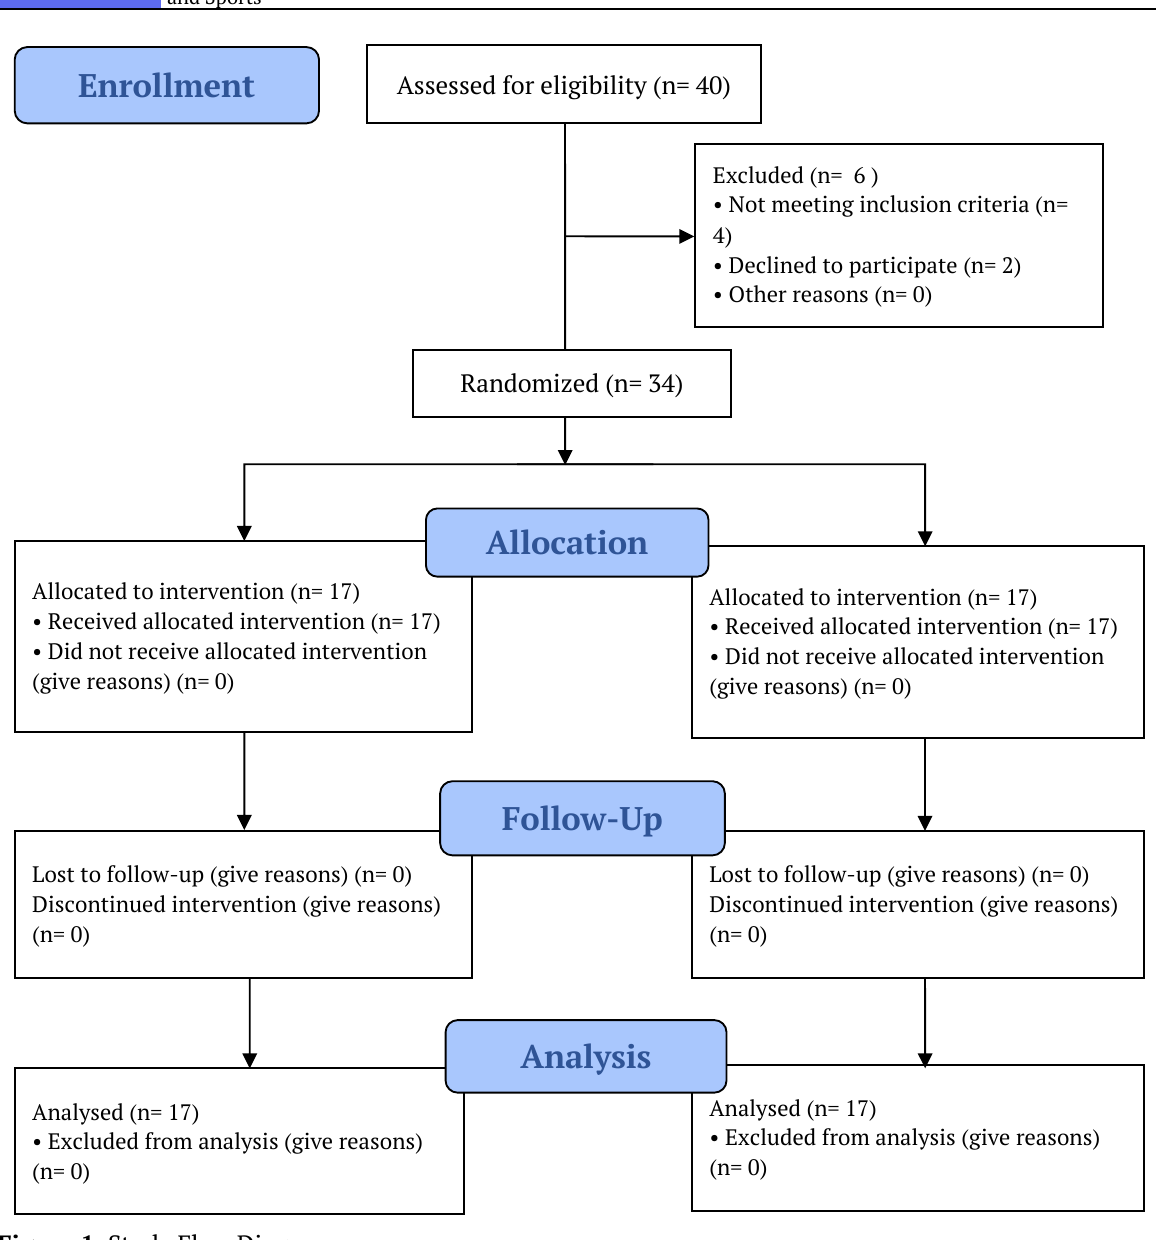
Figure 1. Study Flow